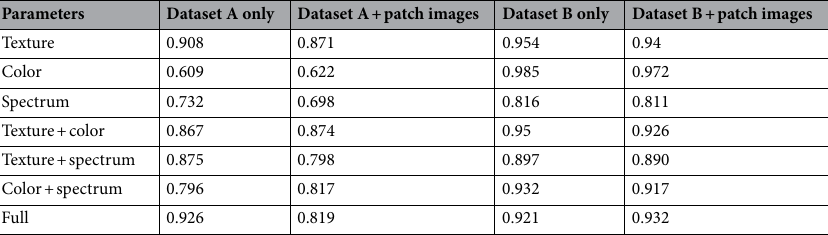
Table 4. Classification results of the k-NN model according to dataset types. It shows the F1-score of the performance of the k-NN model. We trained the classifier using combinations of features extracted from the new dataset (including patch images) or the initial dataset and identified the difference in the classification performance of the k-NN model.